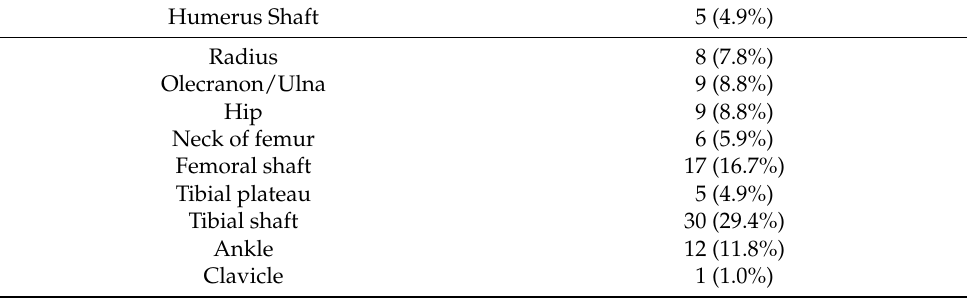
Table 2. Location of fracture related infection.